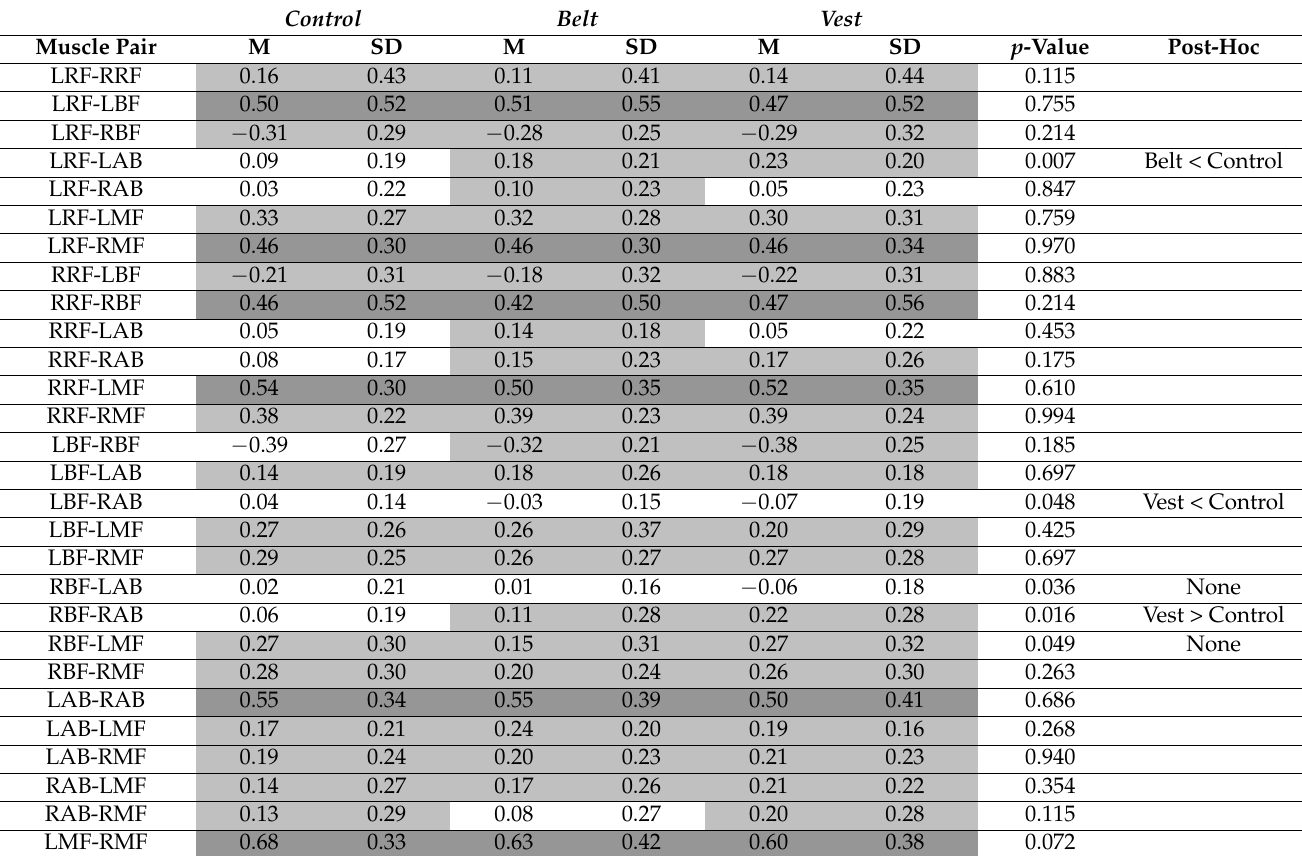
Table 2. Correlation coefficients of muscles between conditions during